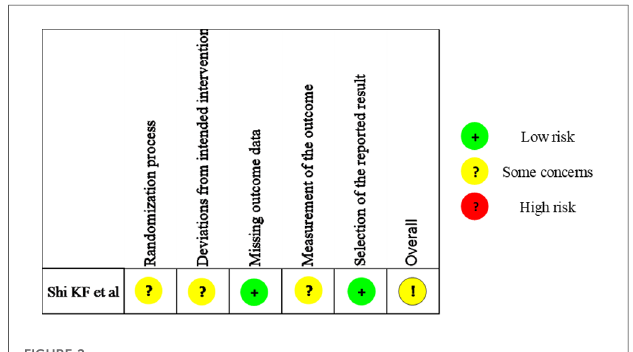
FIGURE 2 Risk of bias assessment of the included randomized controlled trial.